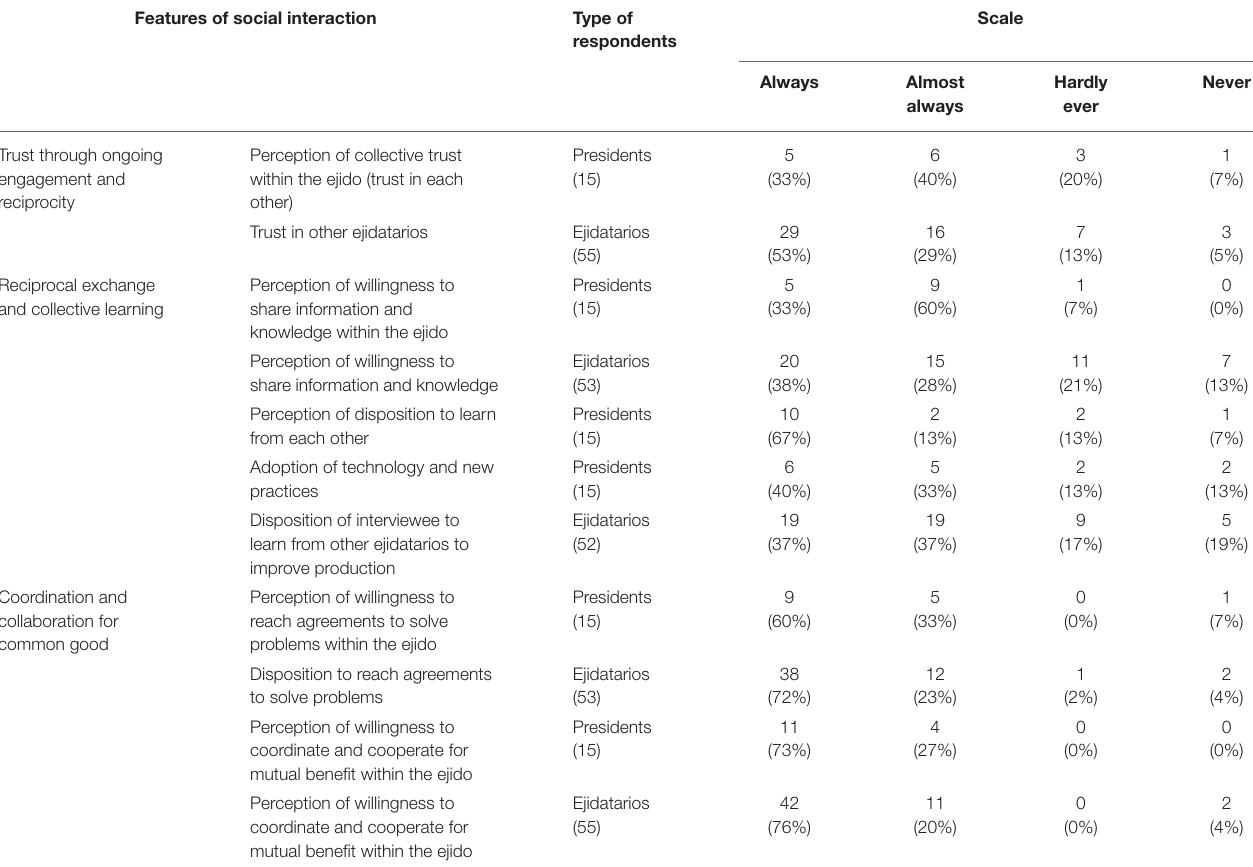
TABLE 2 | Features of social interaction (within the context of social capital) that foster collective agency in ejidos. Features of social interaction Type of respondents